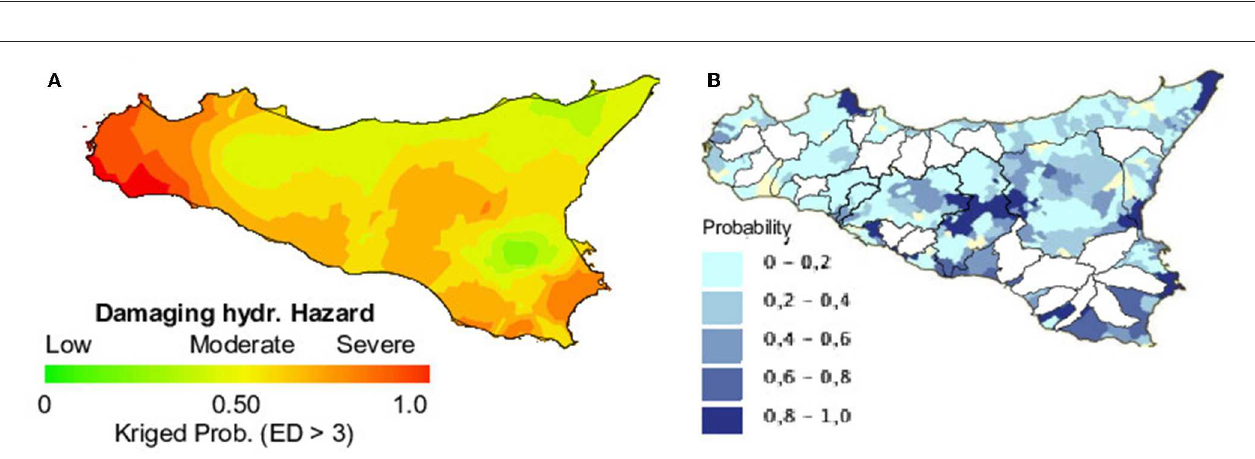
FIGURE 7 | Scatterplot of cross-validation between storm erosivity measured and indicator probability kriging for the erosivity-thresholds z k (ED > 3 MJ ha − 1 h − 1 ), for (A) August, (B) September, and (C) October month. The blue vertical lines in both the graphs represent the respective ED thresholds, while the gray horizontal lines separate the kriged-prediction indicator with probability above 0.50 from those below 0.50.